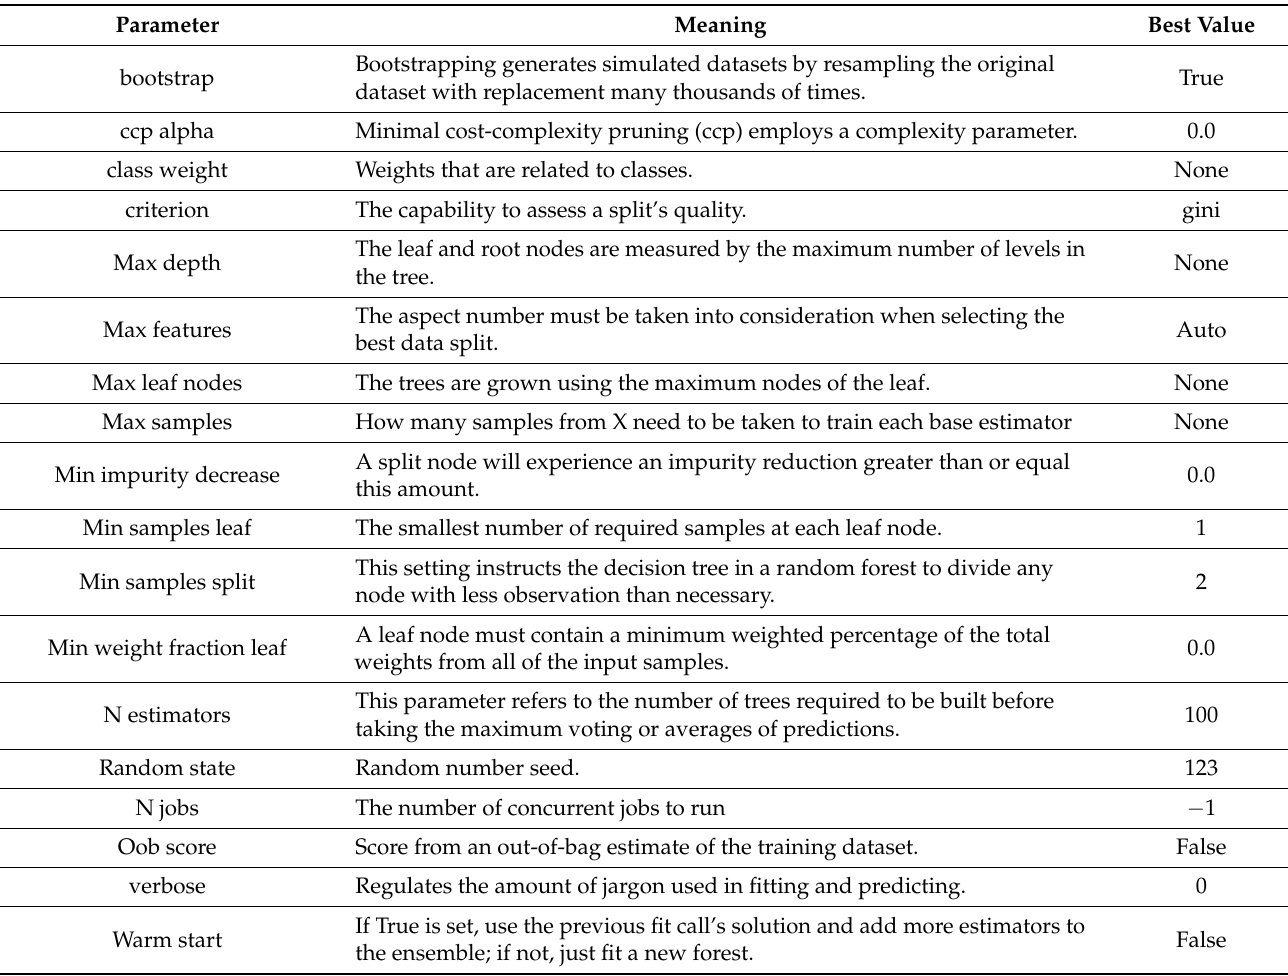
Table 4. Tuned parameters for